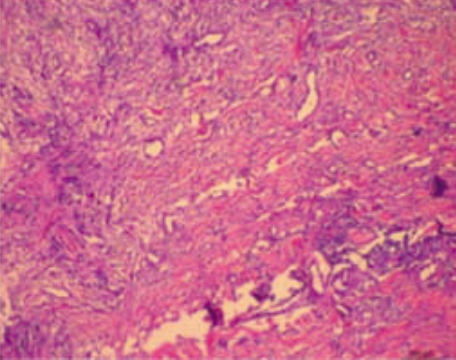
Fig. 3. Histomorphograph of oesophageal Nodules (Haematoxylin and Eosin,10X) (10X,A12)